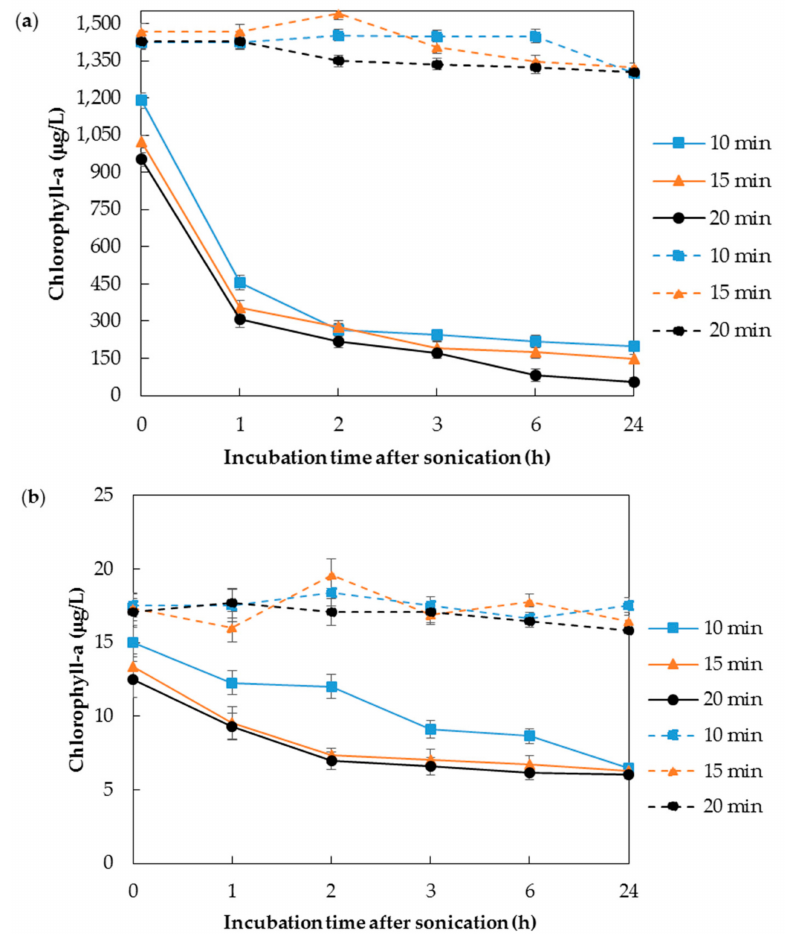
Figure 4. Effect of 10, 15, and 20 min sonication on the water column of ( a ) outbreak alert level concentration with initial value 1414 to 1469 µ g/L; ( b ) caution level with initial values of 17.1 to 17.5 µ g/L. The solid lines, , and represent 10, 15 and 20 min treated suspensions, respectively and the broken lines, , and represent control groups corresponding to 10, 15, and 25 min treatment,